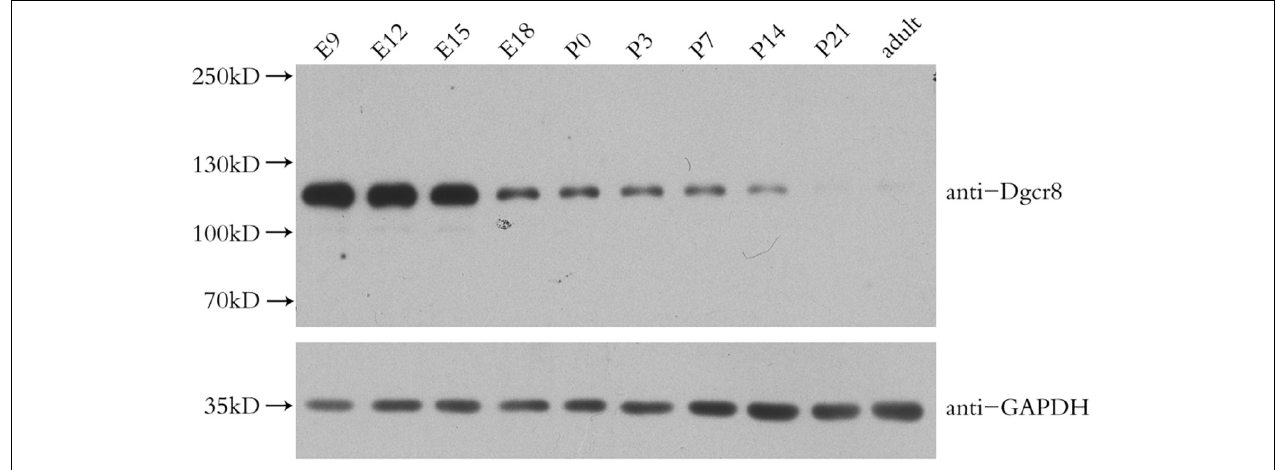
FIGURE 4 | Western blot analysis of Dgcr8 protein levels in mice neocortex during cortical development at the indicated time points, including embryonic day (E) 9, 12, 15, 18, and postnatal day (P) 0, 3, 7, 14, 21 as well as adult age. N = 3 for each time